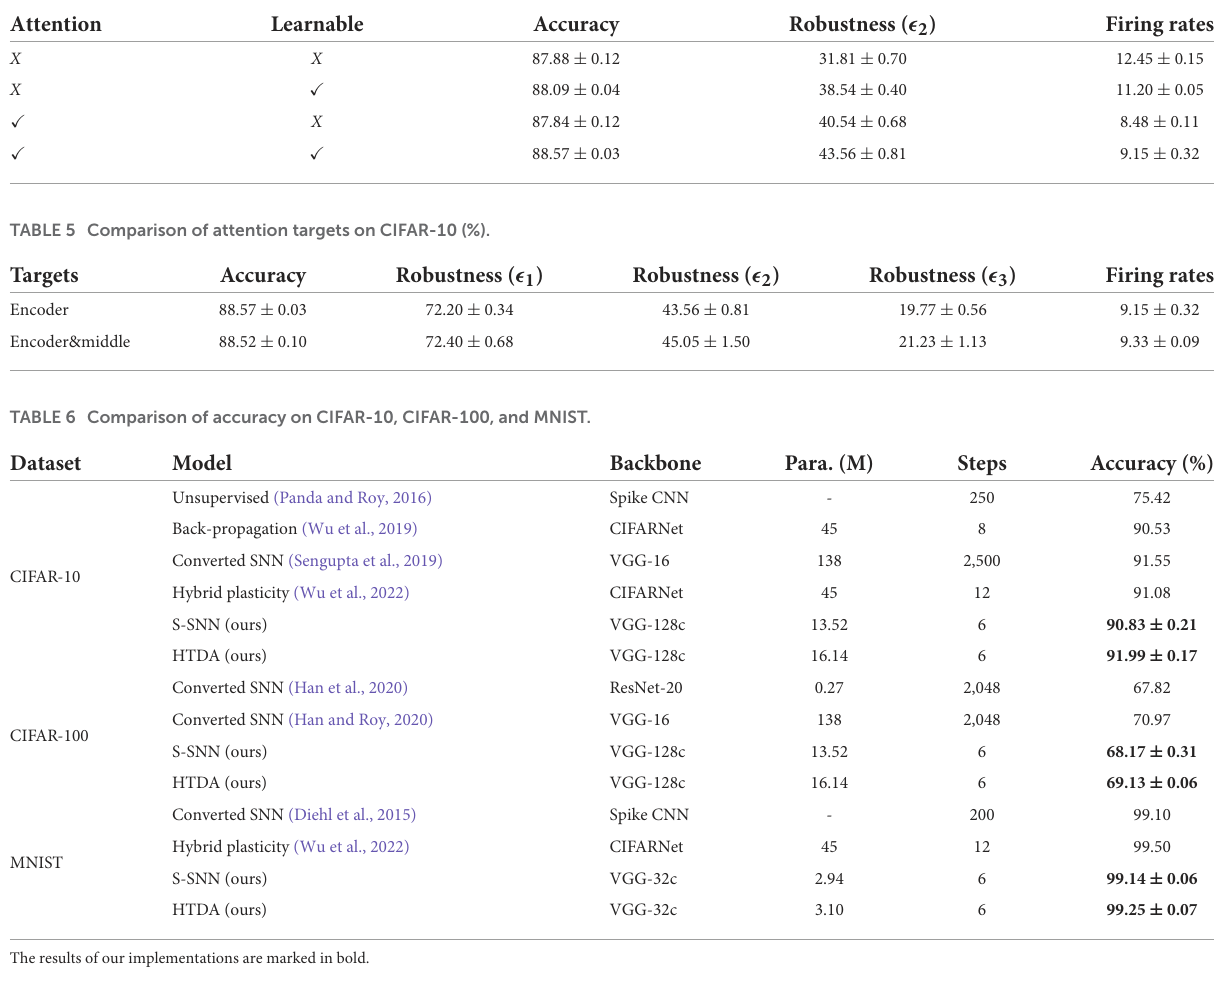
TABLE 4 Comparison of different settings on CIFAR-10 (%).